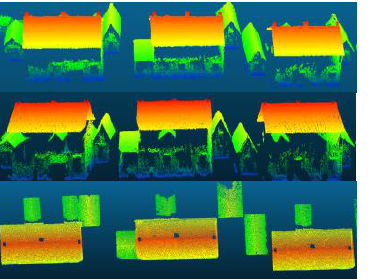
Figure 12. Upper image (before filtering); middle image (after filtering); and the lower image showing removed chimney clouds